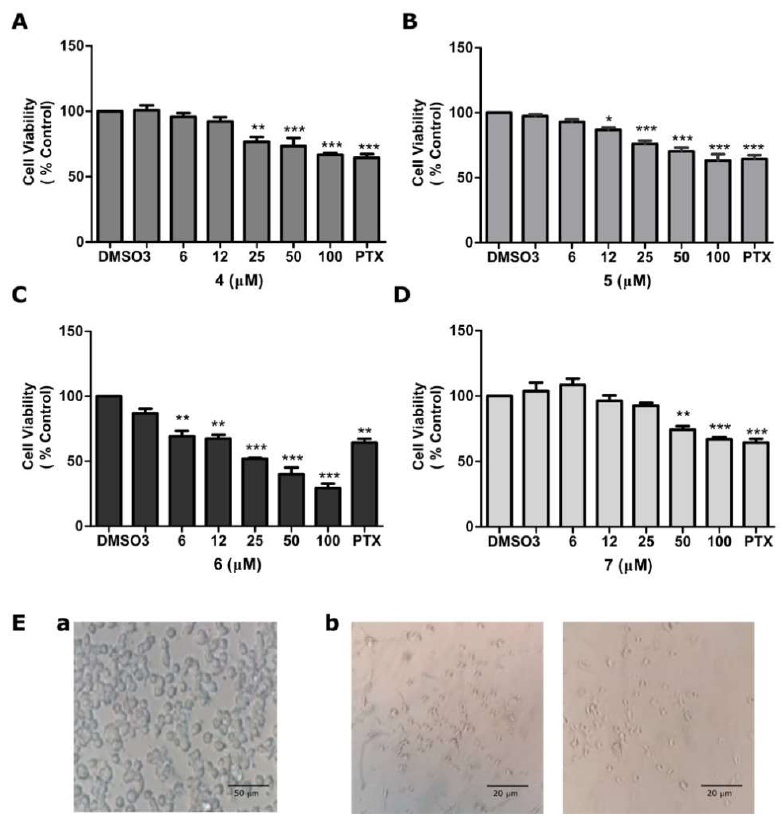
Figure 4. Antiproliferative effects of 4 – 7 on CT26WT cells. Cells at the mid-log phase were seeded in a 96-well plate at 1 × 10 4 cells density in 100 µL medium. After being cultured overnight, cells were exposed to compounds 4 , 5 , 6, 7 (3, 6, 12, 25, 50 and 100 µM) and Placlitaxel (PTX) (50 µM) for 24 h. The cells were incubated with MTT (5 mg/mL) for 4 h. Inhibitory effects of 4 ( A ), 5 ( B ), 6 ( C ) and 7 ( D ) in cell viability of CT26WT cells were determined by the MTT assay. Data are presented as mean ± SD (n = 3), results of an ANOVA, and the Dunnet Test. Significance: * p < 0.05, ** p < 0.01, *** p < 0.001 vs. negative control (DMSO). ( E ) Representative pictures: ( a ) untreated cells, ( b ) morphological changes induced by compound 6 at 50 µM.